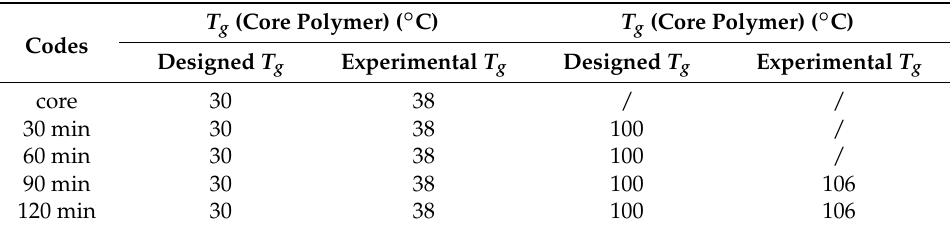
Table 2. Designed and experimental glass transition temperature ( T g ) of film samples.